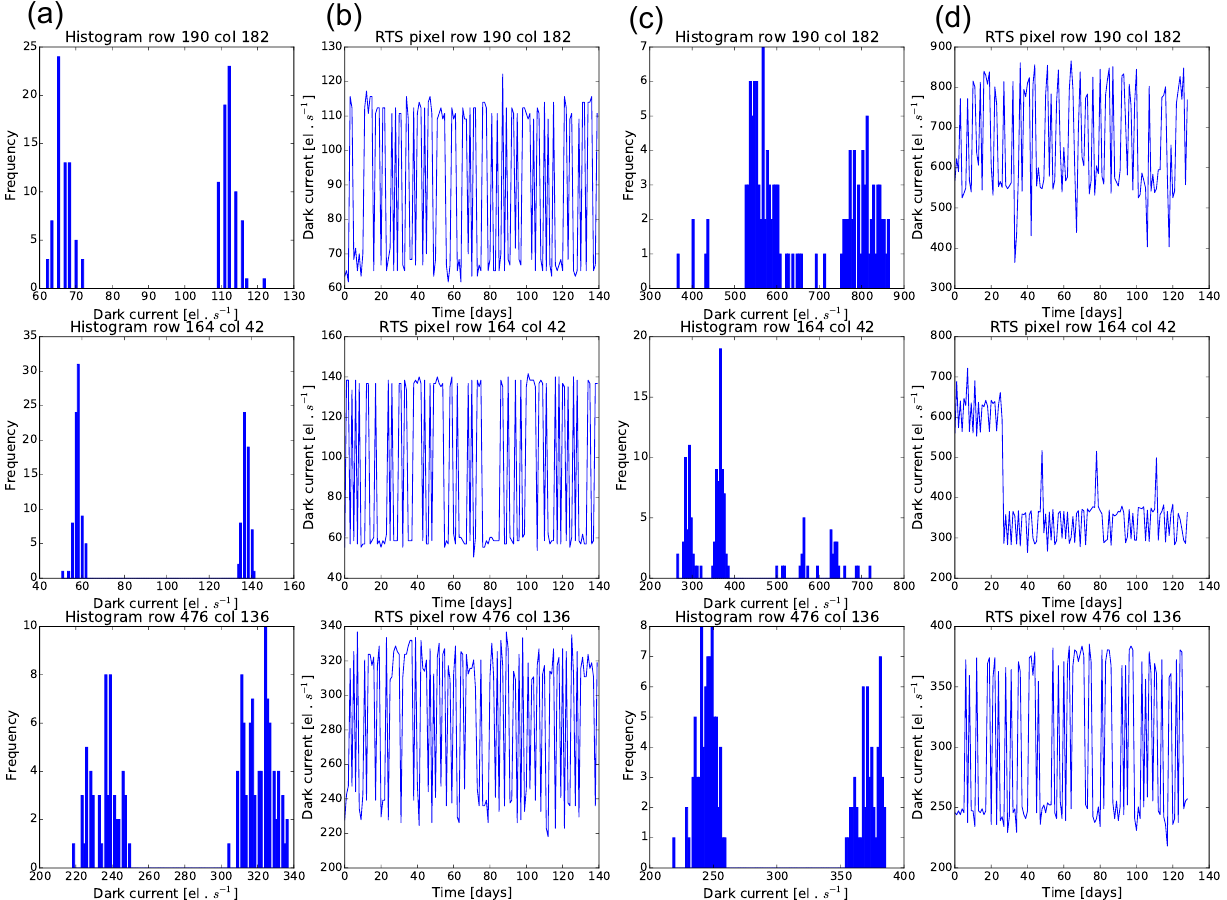
Figure 14. Examples of RTS pixels. The left two columns show results for 2008, and the right two columns show results for 2015. (a) and (c) show histograms of RTS pixels. (b) and (d) show dark-current evolution over time. In 2015 the dark current and noise are higher, which gives the histograms a smoother character. Note the different scales that are used for 2008 and